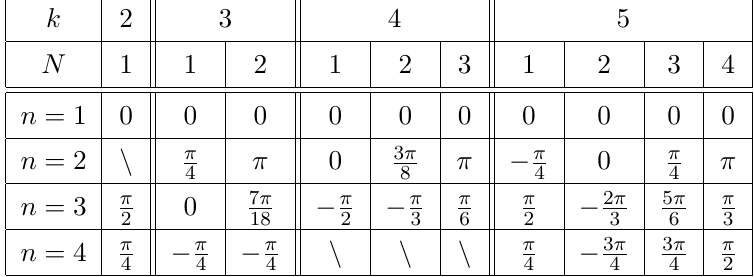
h i U ( N ) with b = 1 . The duality between k, 0